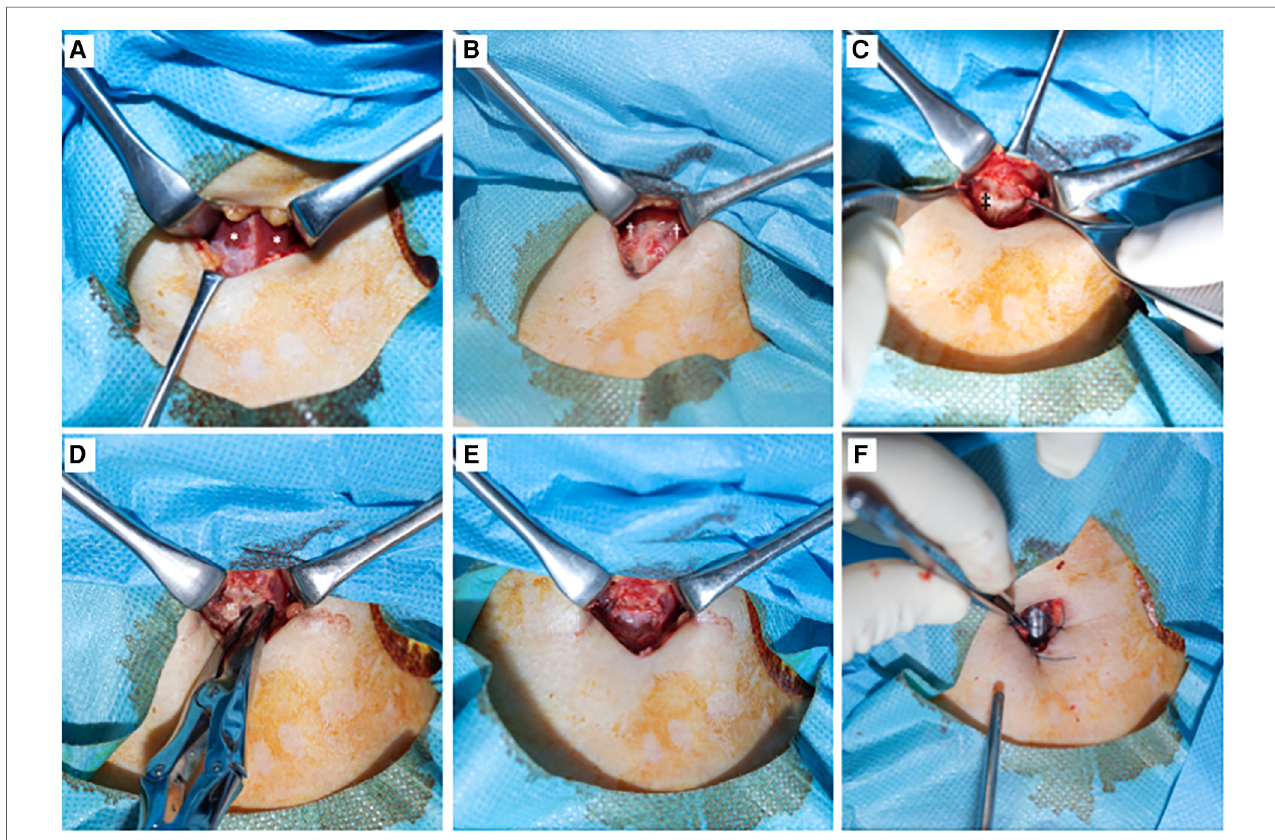
FIGURE 1 Surgical procedure of cricotracheostomy. ( A ): After vertical skin incision. Bilateral muscles sternohyoideus were exposed. *: muscles sternohyoideus. ( B ): Muscles sternohyoideus were divided at midline. Muscles cricothyroideus were observed. † : muscles cricothyroideus. ( C ): Cricoid cartilage was observed after dissected perichondrium. ‡ : cricoid cartilage. ( D ): The anterior portion of the cricoid cartilage was removed. ( E ): After cricoid cartilage was removed, tracheal mucosa was observed. ( F ): An incision was made in the membranous tissue and the fl ap was sutured to the skin. Endotracheal tube was observed in the